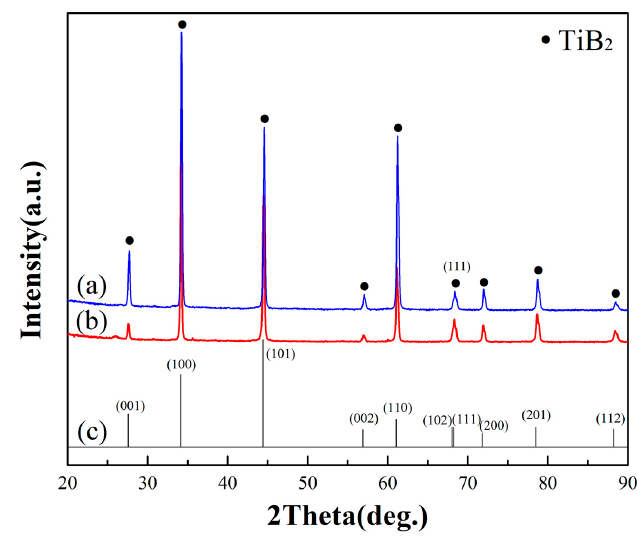
Figure 2. XRD (X-ray diffraction) patterns of TiB 2 deposits. ( a ) At a gas flow ratio of TiCl 4 /BCl 3 = 0.5; ( b ) at a gas flow ratio of TiCl 4 /BCl 3 = 1; ( c ) TiB 2 standard data from JCPDS (Joint Committee on Powder Diffraction Standards) card No. 85-2083.